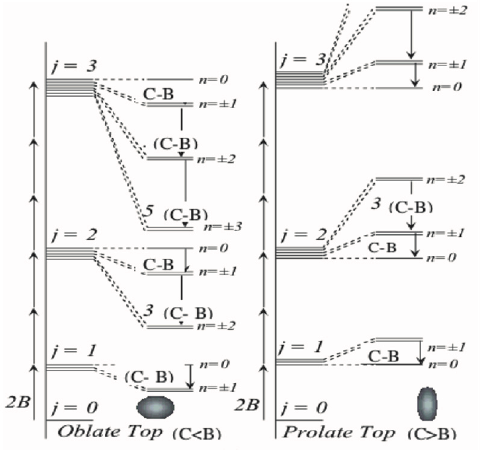
Figure 14. Quantum rotor levels for (cid:1836) = 0,1,3, …